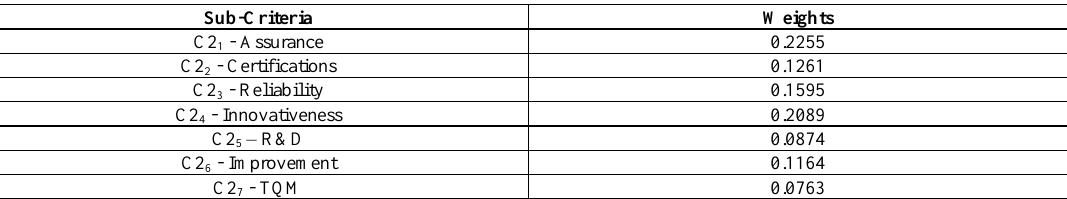
Table 4. Weights of sub-criteria within quality issues